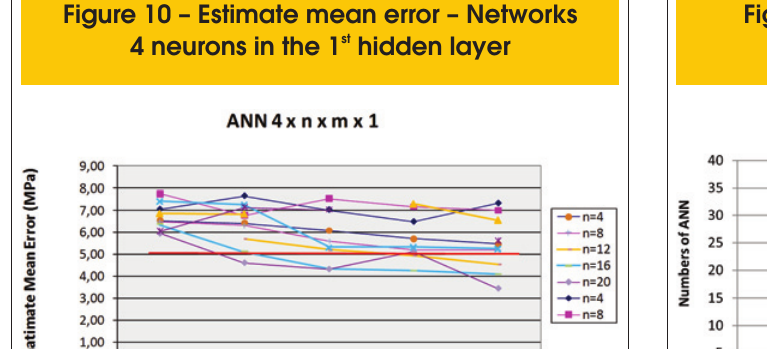
Figure 10 – Estimate mean error – Networks st 4 neurons in the 1 hidden layer